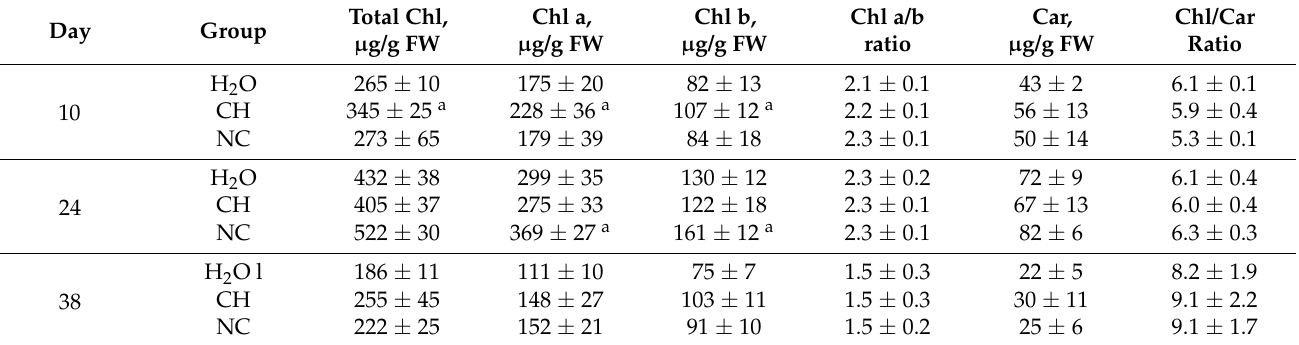
Table 4. Effect of CH, NC, and H 2 O on photosynthetic pigments at different stages of